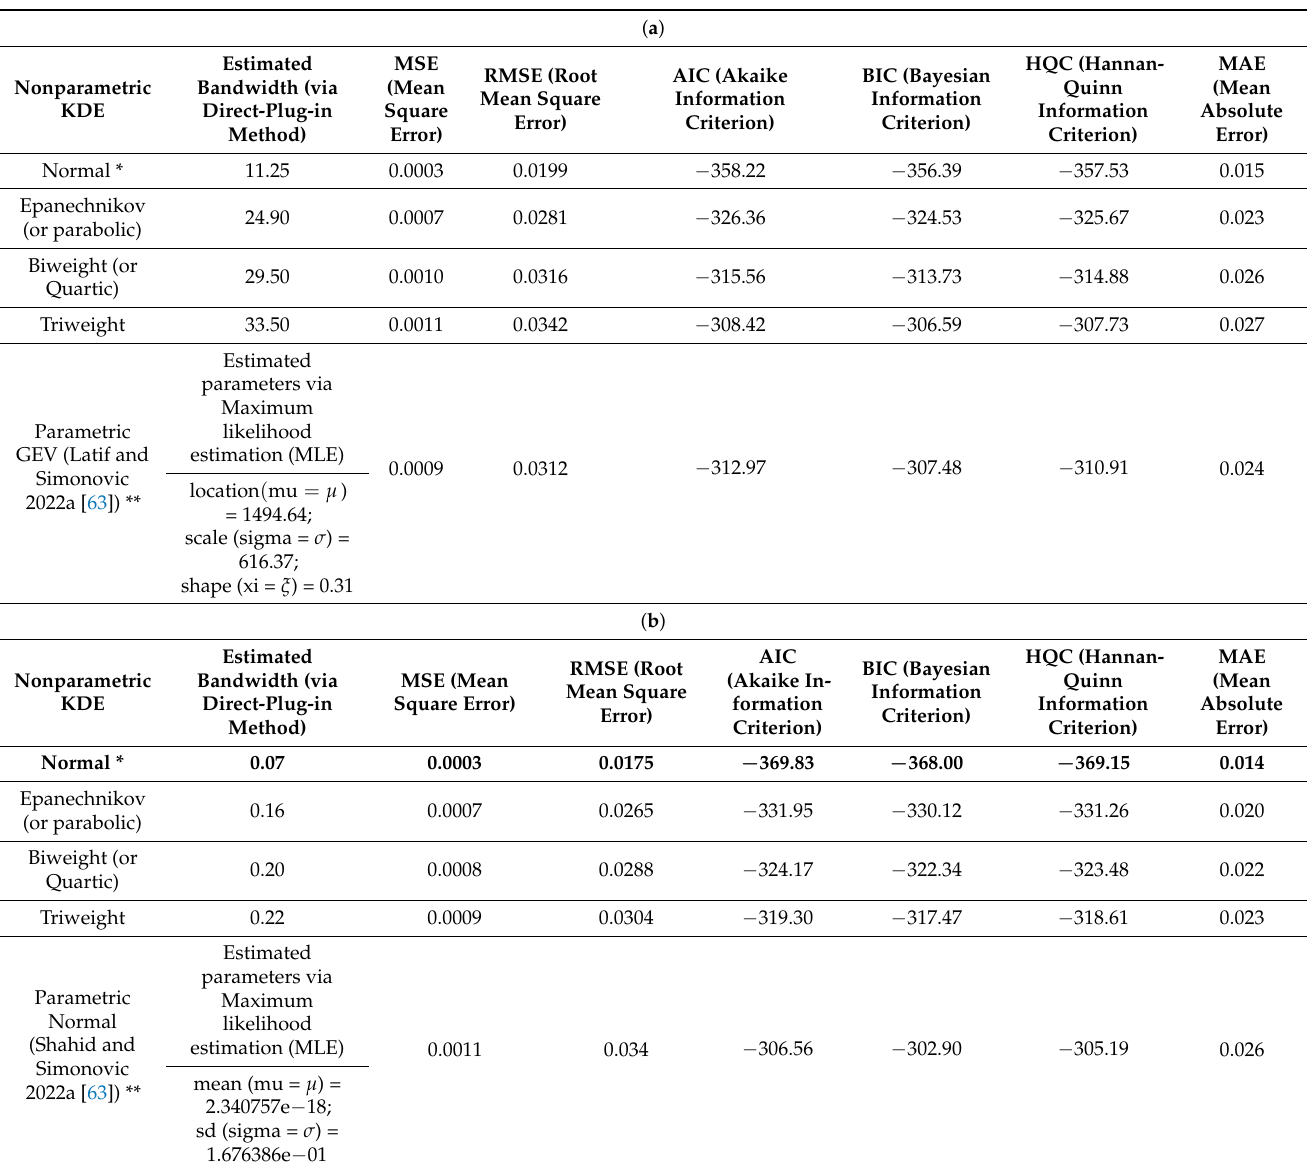
Table 2. Fitting univariate kernel density estimation (KDE) and their goodness-of-fit (GOF) test